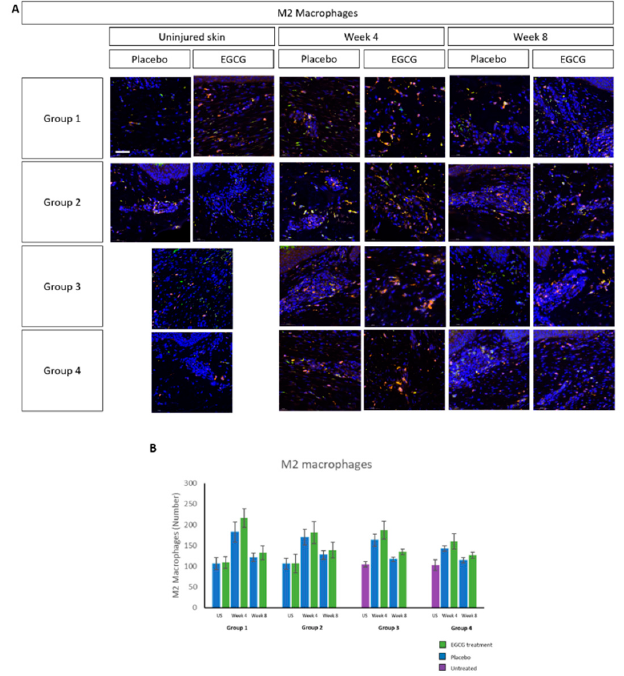
Figure 10. Immune cell analysis of total number of M2 macrophages in whole tissue. ( A ) There was an increase in M2 macrophages in both treated and placebo samples, with greater numbers seen in EGCG-treated scars by week 4 after injury compared with placebo scars. ( B ) Measurements showed that levels were similar when comparing placebo with EGCG treated samples at each time point. Scale bars = 50 μ m.